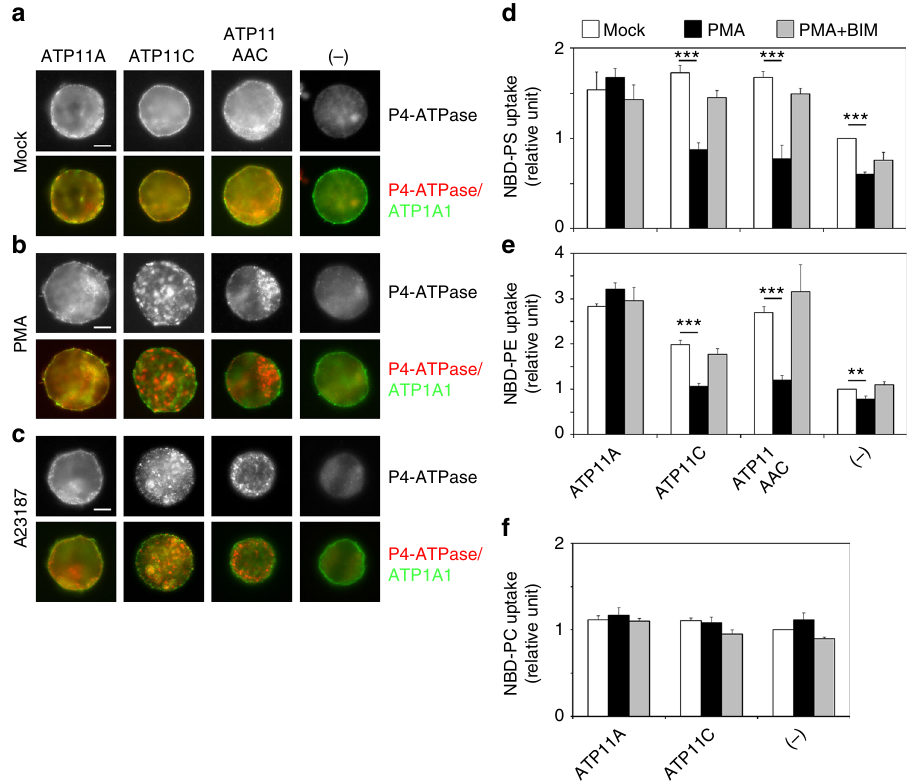
Fig. 5 C-terminus of ATP11C is required for inhibition of fl ippase activities by PKC activation. a – c Ba/F3 cells stably expressing HA-tagged ATP11A, ATP11C, and ATP11AAC chimeric proteins were treated with vehicle alone ( a ), 400 nM PMA ( b ), or 1 μ M A23187 in the presence of CaCl 2 ( c ) for 15 min. The cells were fi xed and immunostained with anti-HA and anti-ATP1A1 antibodies, followed by incubation with Cy3-conjugated anti-rat and Alexa Fluor 488-conjugated anti-rabbit secondary antibodies. Scale bars, 5 μ m. d – f Ba/F3 cells were treated with vehicle alone (white bars), 400 nM PMA (black bars), or 400 nM PMA and 2 μ M of BIM-1 (gray bars) for 15 min. The cells were then washed with fl ippase assay buffer and incubated at 15 °C for 5 min with NBD-PS ( d ), or 15 min with NBD-PE ( e ) or NBD-PC ( f ). After extraction with fatty acid-free BSA, the residual fl uorescence intensity associated with the cells was determined by fl ow cytometry. Fold increase of NBD-lipids uptake is shown relative to that in Mock-treated parental Ba/F3 cells ( − ). Graphs display averages from three independent experiments ± SD. ** p < 0.005; *** p < (Fig. 5e), suggesting that the substrate preference of ATP11AAC is similar to that of ATP11A. Ser1116 is critical for PMA-induced endocytosis of ATP11C . The C-terminal cytoplasmic region of ATP11C contains eight serine residues (S1097, S1103, S1108, S1110, S1112, S1116, S1126, and S1129) and one threonine residue (T1124), as shown in Fig. 6a. Among the nine Ser/Thr residues, eight (with the exception of S1097) are registered as phosphorylated sites in the public phosphosite database (PhosphoSitePlus, http://www. phosphosite.org/). Therefore, we investigated the possibility that those Ser/Thr residues in C-terminal region of ATP11C partici- pate in its endocytosis upon PKC activation. To this end, we replaced each Ser/Thr residue with Ala, transiently expressed each Ala mutant in HeLa cells, and observed protein localization fol- lowing PMA treatment (Supplementary Fig. 3a). When Ser1116 was replaced with Ala (S1116A), PMA-induced internalization of ATP11C was completely blocked (Supplementary Figs 3a and 6b).